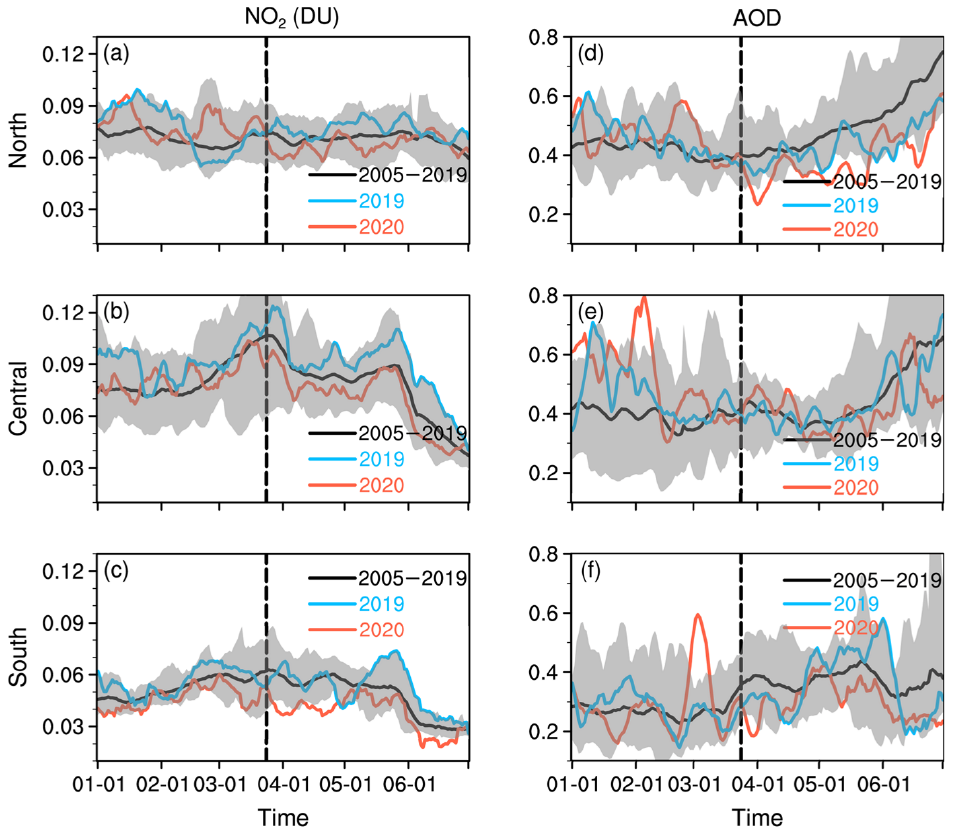
Figure 3. Time series of the tropospheric NO 2 and total column AOD over three subregions in the Indian subcontinent (Figure 1). ( a – c ): tropospheric NO 2 and ( d – f ): AOD. The black, light-blue, and light-red lines respectively represent the 2005–2019 climatology, 2019, and 2020 time series. The grey shadings indicate the fifteen-year spread. The vertical black dash line indicates the initiation of lockdown on 24 March 2020.